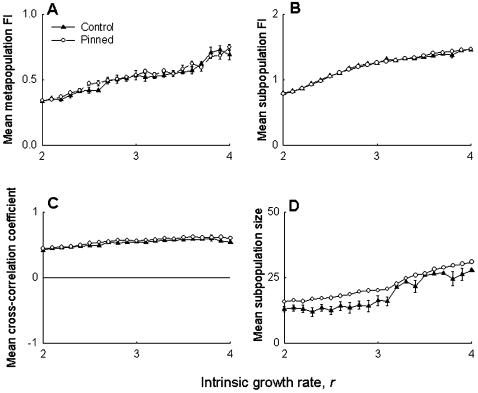
Simulations mimicking experiment: effect of pinning at the metapopulation level. Ricker based simulations predicted no difference in (A) metapopulation stability, (B) subpopulation stability, and (C) synchrony amongst nearest-neighbors, between the control and pinned metapopulations. (D) The simulations suggested a slight decrease in subpopulation size for low values of r, which was not picked up by the experiment. Overall, these results agree with the corresponding experimental findings (Fig 2), indicating that they are likely to be applicable to other species.